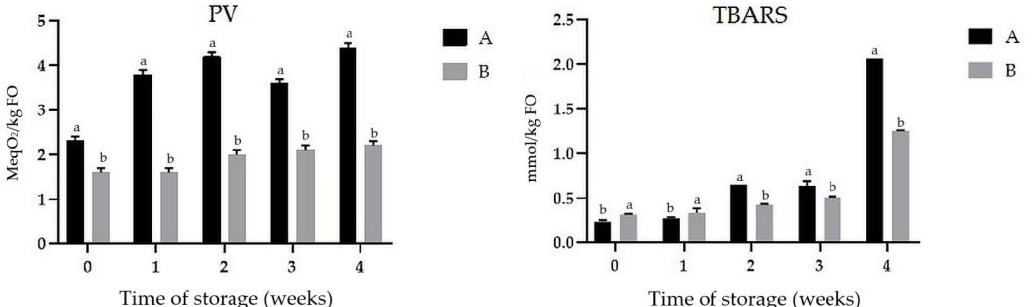
Figure 3. Peroxide values (PV) and thiobarbituric acid-reactive substances (TBARS) in powders with 10% ( A ) and 20% ( B ) content of FO. Means with different lowercase letters are significantly different at p < 0.05.